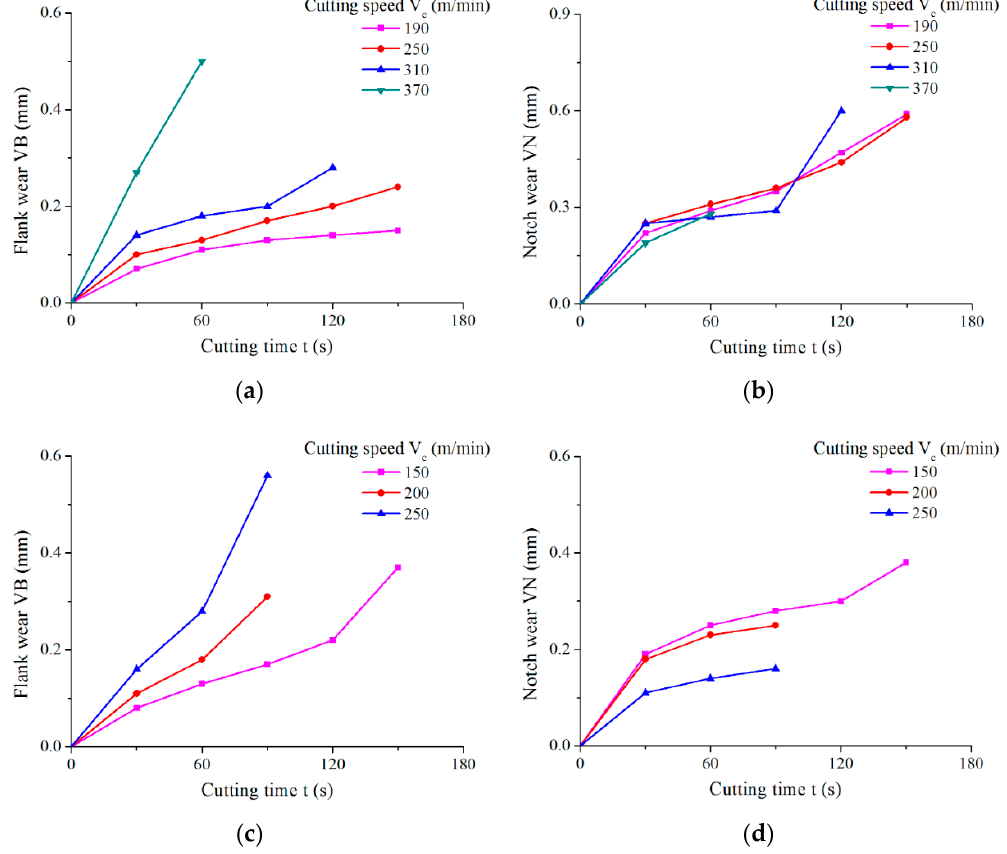
Figure 2. Tool wear curves at different cutting speeds: ( a ) VB of WG300; ( b ) VN of WG300; ( c ) VB of SX9; ( d ) VN of SX9.